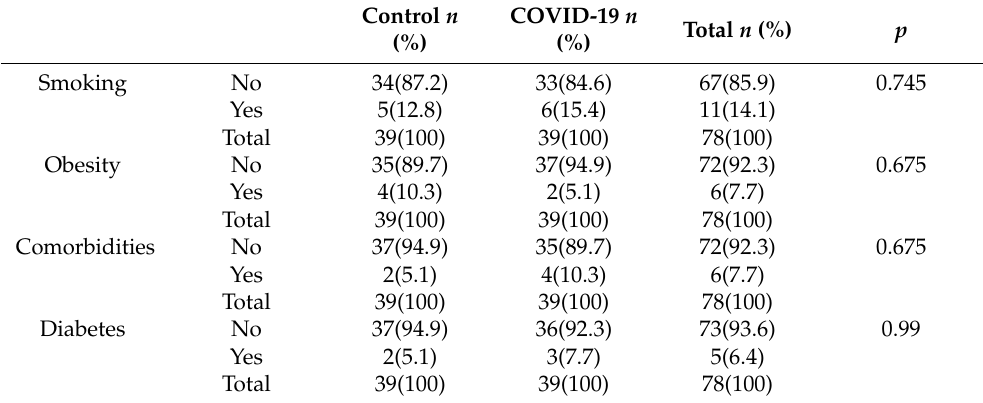
Table 6. Univariate analysis of the variables.